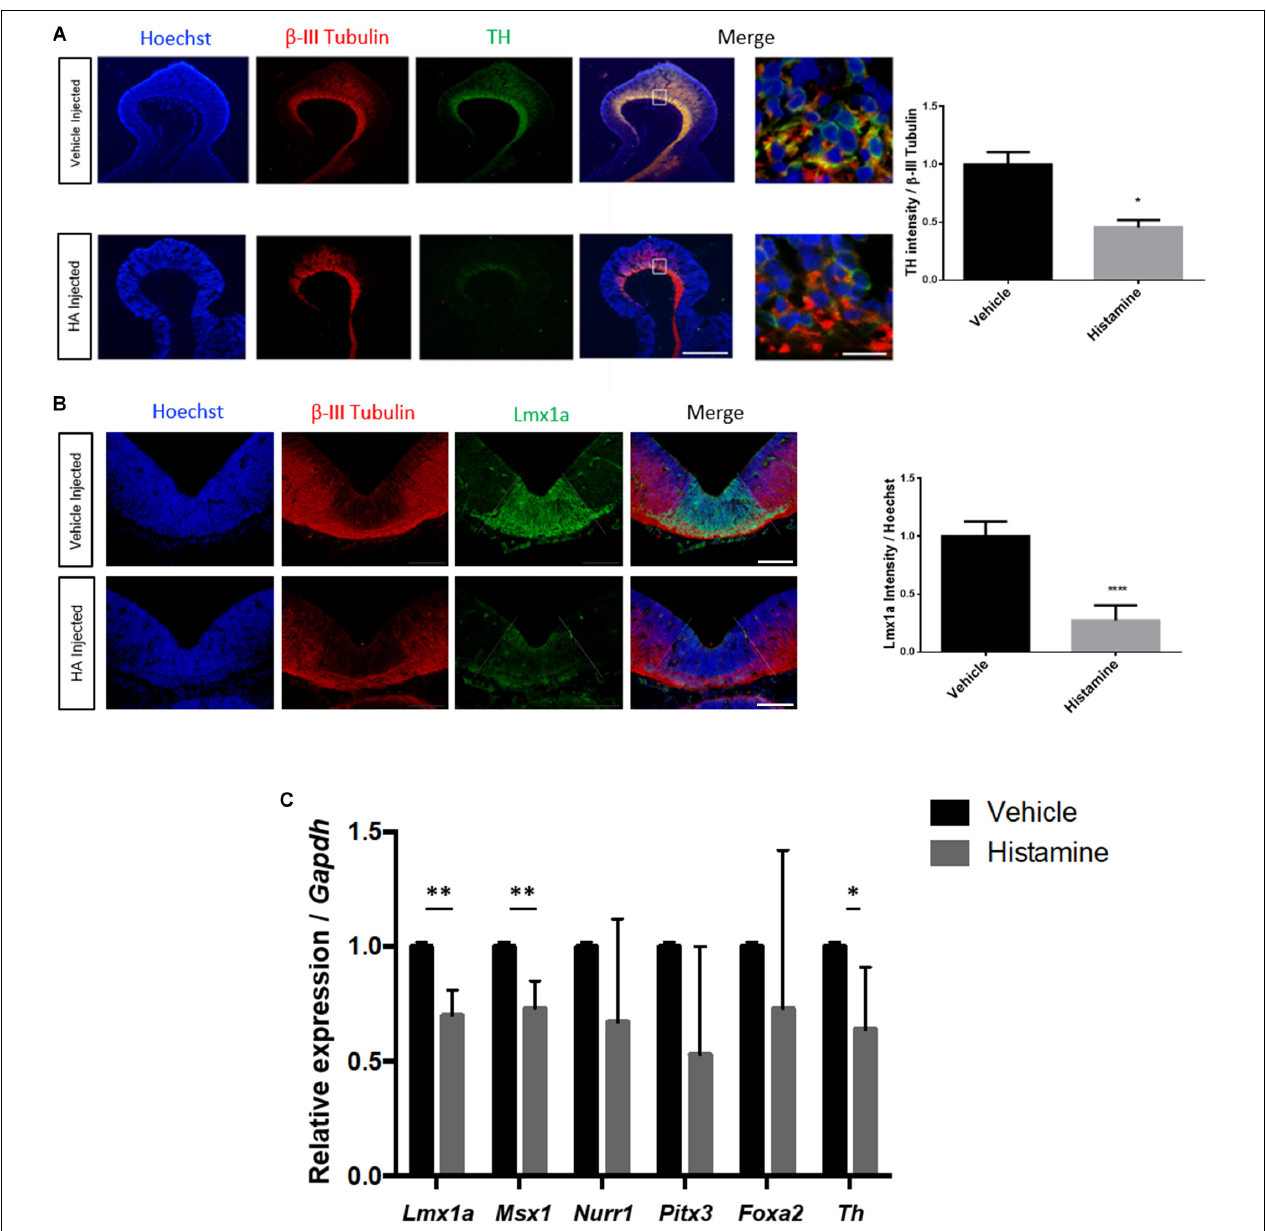
FIGURE 1 | HA decreases TH and Lmx1a immunoreactivity and down-regulates dopaminergic genes in the ventral midbrain (VM) after in utero injection. Rat embryos were injected at E12 and analyzed 2 days later. (A) Immunohistochemistry showing a significant decrease, caused by HA, in the DA marker TH, in sagittal sections. The neuronal marker β -III Tubulin was unaffected by HA, and was used to normalize TH immunoreactivity. Nuclei were detected with Hoechst. The white square in the merge image is expanded on the right. Scale bar: 150 µ m in the low-magnification and 10 µ m in the amplification. (B) HA significantly reduces the area positive for the dopaminergic progenitor marker Lmx1a, without affecting β -III Tubulin. The quantification of Lmx1a intensity was normalized by the Hoechst signal. The area of Lmx1a-positive DA progenitor cells is delimited by the dotted lines and was dissected to perform RT-qPCR. Scale bar: 200 µ m. (C) Expression of genes involved in DA differentiation after intrauterine HA or vehicle administration, analyzed at day E14. Data was normalized by Gapdh expression. Vehicle-treated embryos were used as the reference for the 2ˆ– (cid:49)(cid:49) Ct analysis. Graphs represent the mean values with SEM from 3 (A,B) to 5 (C) independent experiments. ∗ p < 0.05, ∗∗ p < 0.01, ∗∗∗∗ p <